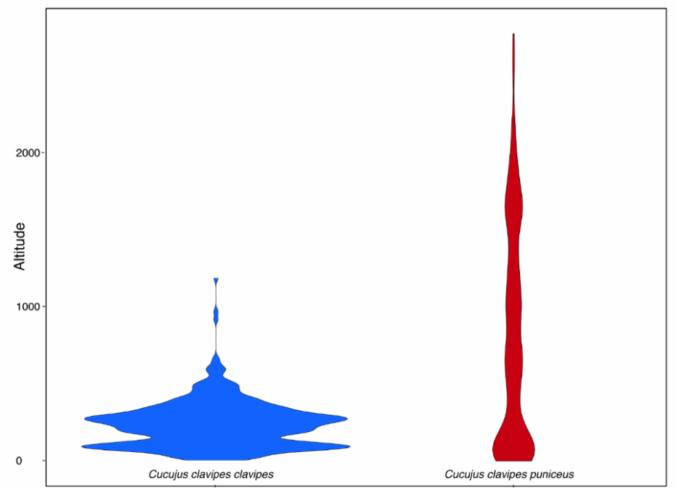
Figure 3. Elevational distribution of Cucujus clavipes clavipes ( n = 368) and C. c. puniceus ( n = 180). Analyses of observations made by iNaturalist citizen scientists show that both sub- species of Cucujus clavipes can be found in various types of macrohabitats including both natural and disturbed areas. In case of C. c. clavipes about 40% of records come from forests while almost 50% from habitats changed by human activity, including agricultural areas where different tree species are growing (ca. 40%) and urban places (ca. 10%). In contrast about 50% records for C. c. puniceus come from various forest types, 10% from open areas with tree and shrub species while agricultural and urban areas are not preferred by this subspecies (Figure